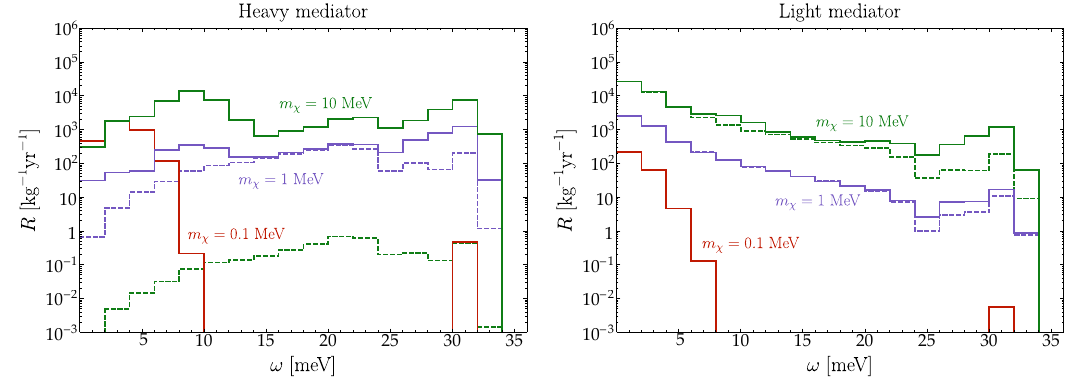
Figure 5 . Di(cid:11)erential rate of single phonon excitations in a GaAs target for m (cid:31) = 0 : 1 ; 1 ; 10 MeV, assuming a heavy (left) or light (right) scalar mediator coupling to nucleons ( f p = f n , f e = 0), with (cid:22) (cid:27) n = 10 (cid:0) 43 cm 2 and ! min = 1 meV. Contributions from momentum transfer within the (cid:12)rst Brillouin zone are shown in dash. Umklapp processes account for the di(cid:11)erences between solid and dashed